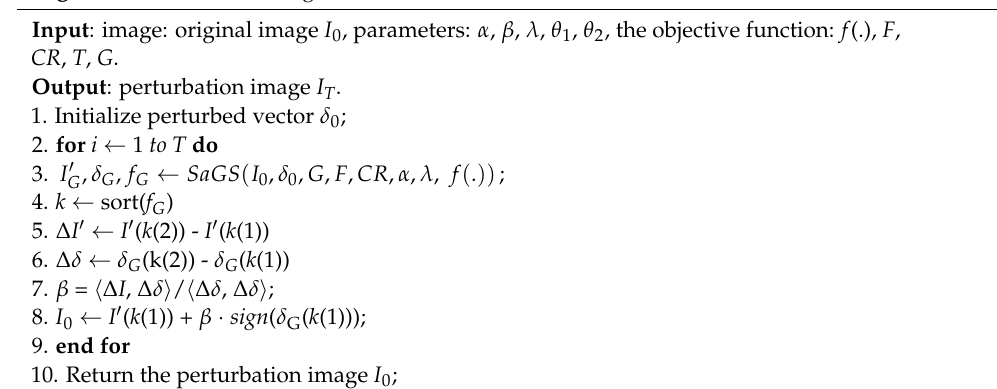
Algorithm 2 : The SAGM